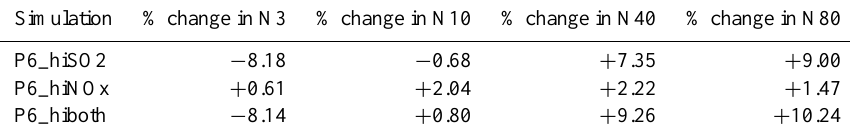
Table 3. Changes in globally, annually averaged N3, N10, N40 and N80 due to 50% increases in emissions from the P6_nXSOA_Napa simulation. Decreases in N3 for the P6_hiSO2 and P6_hiboth cases are due primarily to enchanced coagulation. Increases in N40 and N80 for P6_hiSO2 and P6_hiboth are due primarily to enhanced condensational growth. Increases at all sizes for the P6_hiNOx case are due to enchanced grid-resolved nucleation and growth.